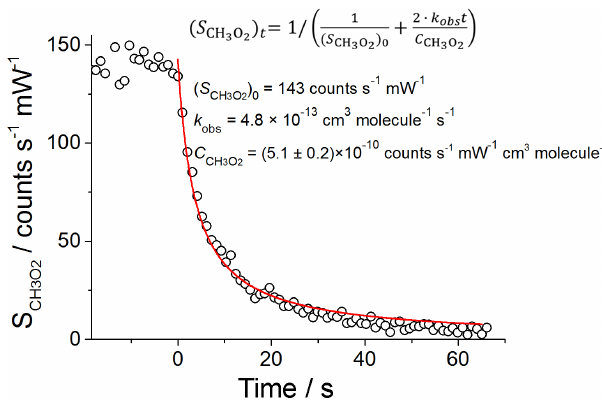
Figure 7. Second-order decay of the normalized CH 3 O 2 signal with 1s time resolution generated in HIRAC using Cl/CH 4 /O 2 and black lamps (see main text for details); [CH 4 ] 0 = 2 . 3 × 10 17 moleculecm − 3 and [Cl 2 ] 0 = 5 . 8 × 10 13 moleculecm − 3 at 295K and 1bar mixture of N 2 :O 2 = 4:1. At time zero the lamps were turned off. Fitting Eq. (6) to the data yielded C CH ( 5 . 1 ± 0.2) × 10 − 10 counts cm 3 molecule − 1 s − 1 mW − 1 (statistical error at 1 σ